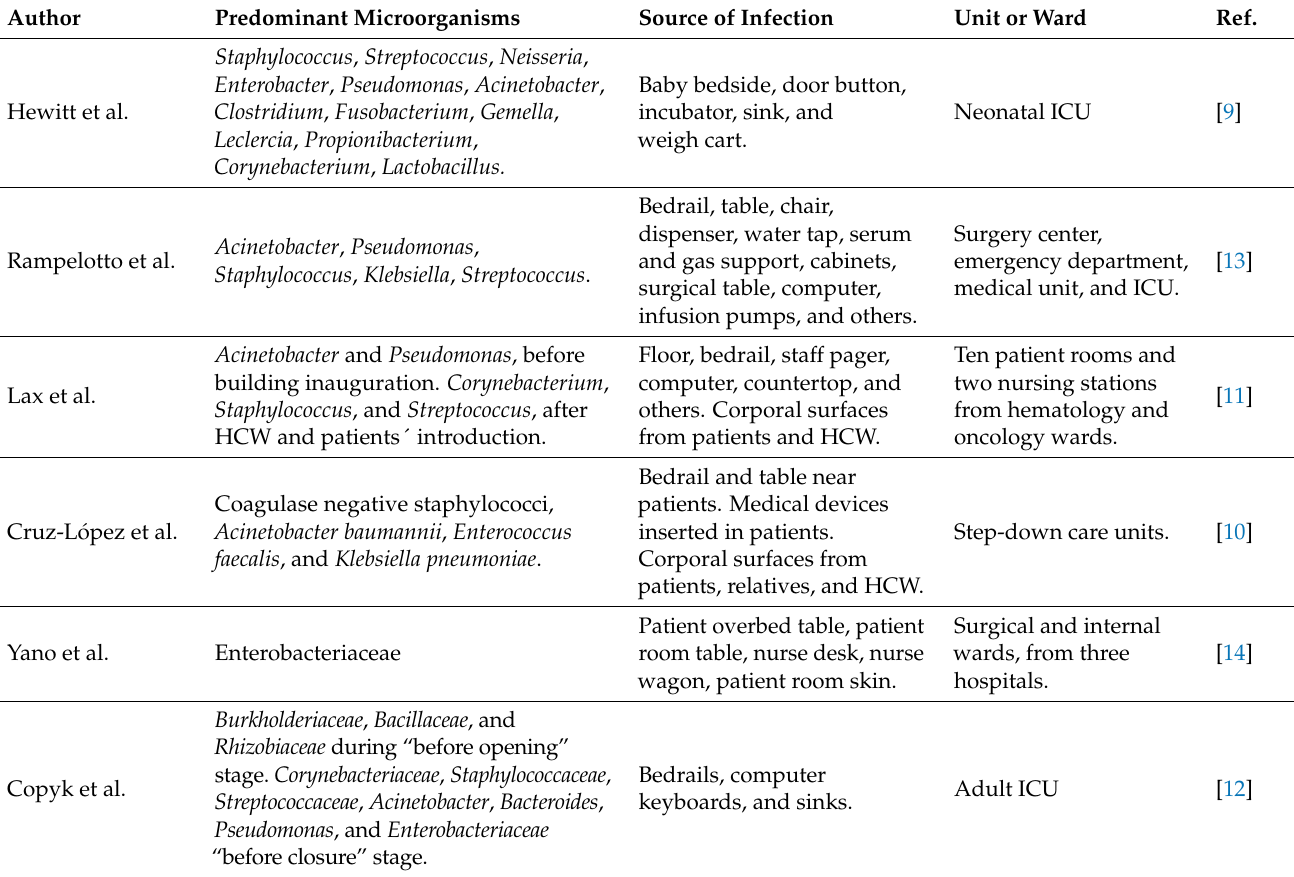
Table 1. Sources of infection in hospital